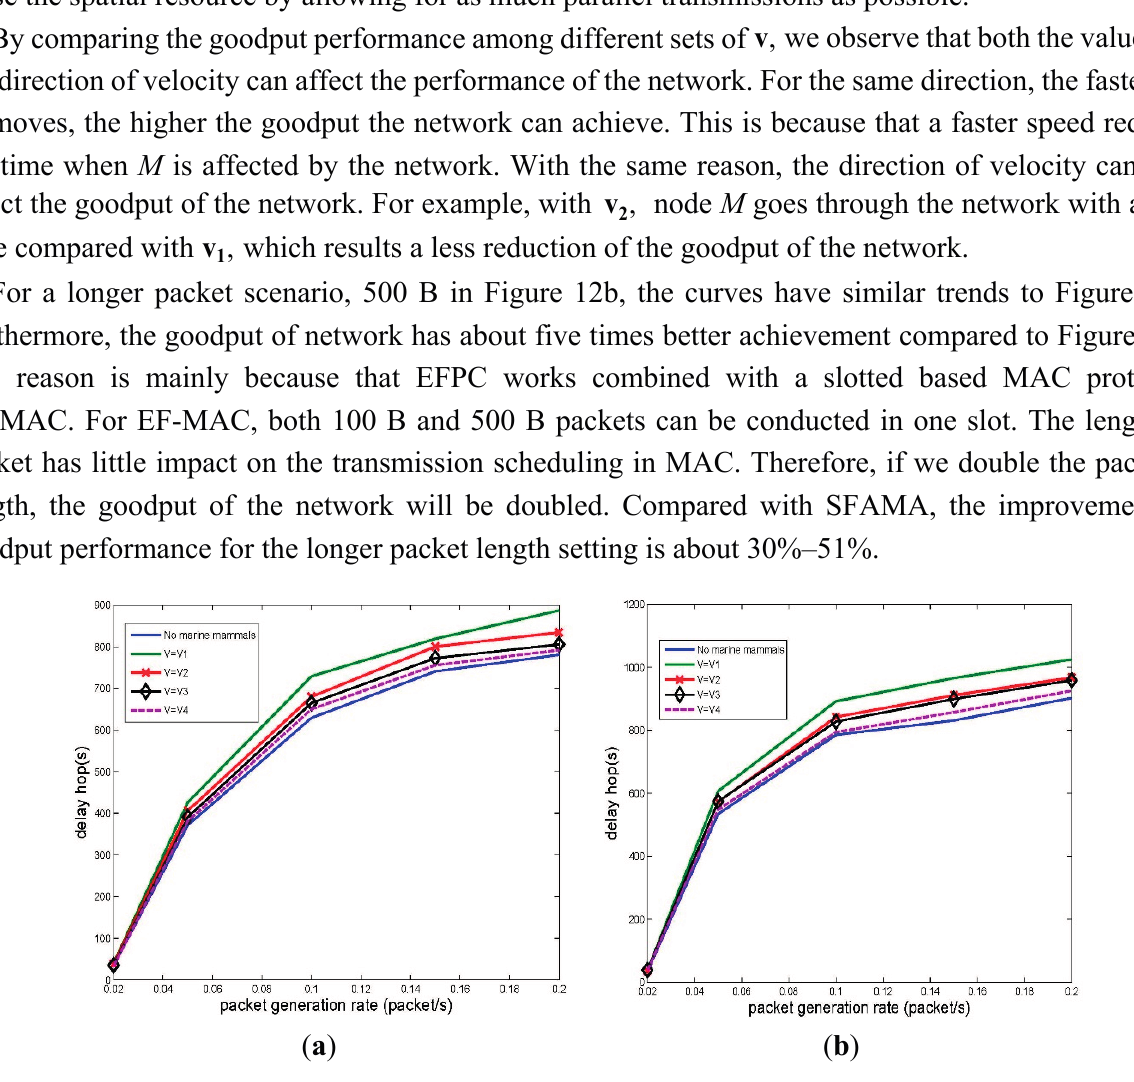
Figure 13. Network delay. ( a ) Packet length 100 B; ( b ) Packet length 500